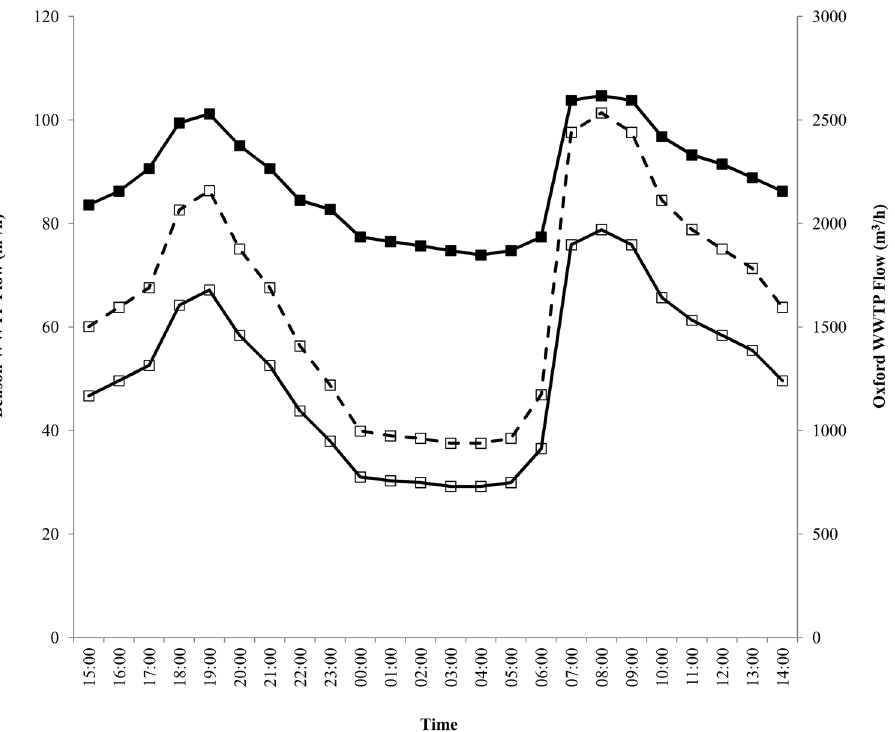
Figure 1. Waste Water Treatment Plant Flow. Hourly flow (m 3 /h) from Benson (open) and Oxford (shaded) WWTP on sampling days 11 November 2009 (solid line) and 10 May 2011 (dashed line).